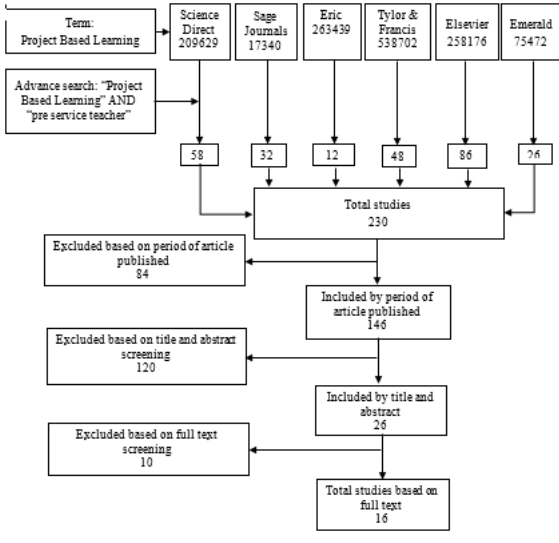
Figure 1: Search procedure of